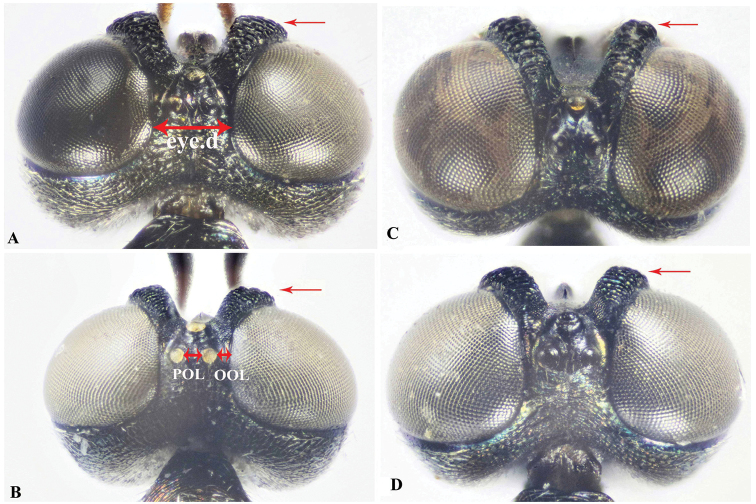
Dorsal view of head, Holotype AOodera
arabica sp. nov. BOodera
omanensis sp. nov. COodera
rapuzzii sp. nov. DOodera
similis sp. nov. (coronal structure indicated).